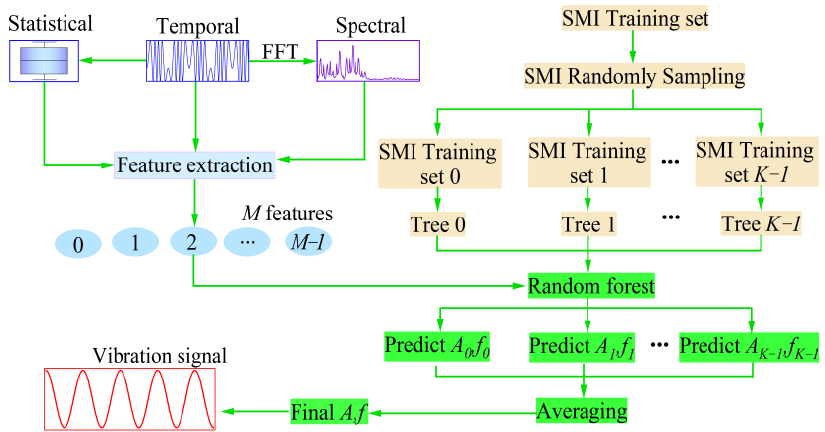
Figure 3. Vibration measurement framework combining RF and SMI.